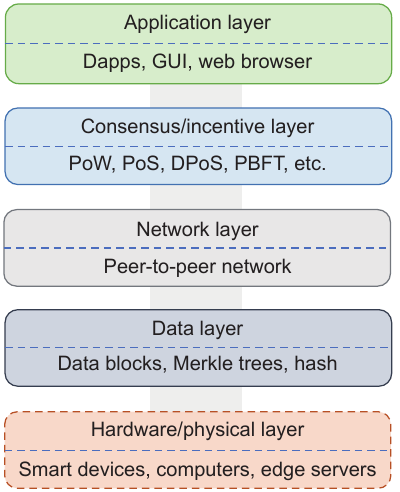
Fig. 2 A typical architecture of blockchain systems.